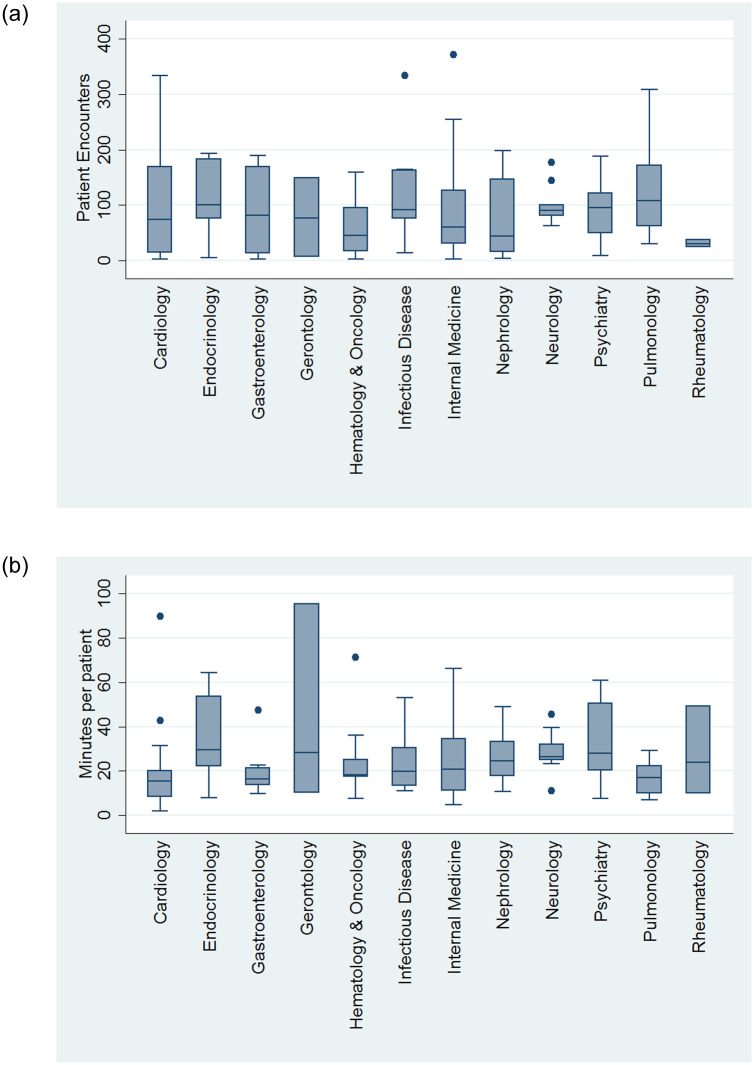
(a) Total number of patient encounters in 2 week period by different specialty. (b) Time spent per patient by different specialties.